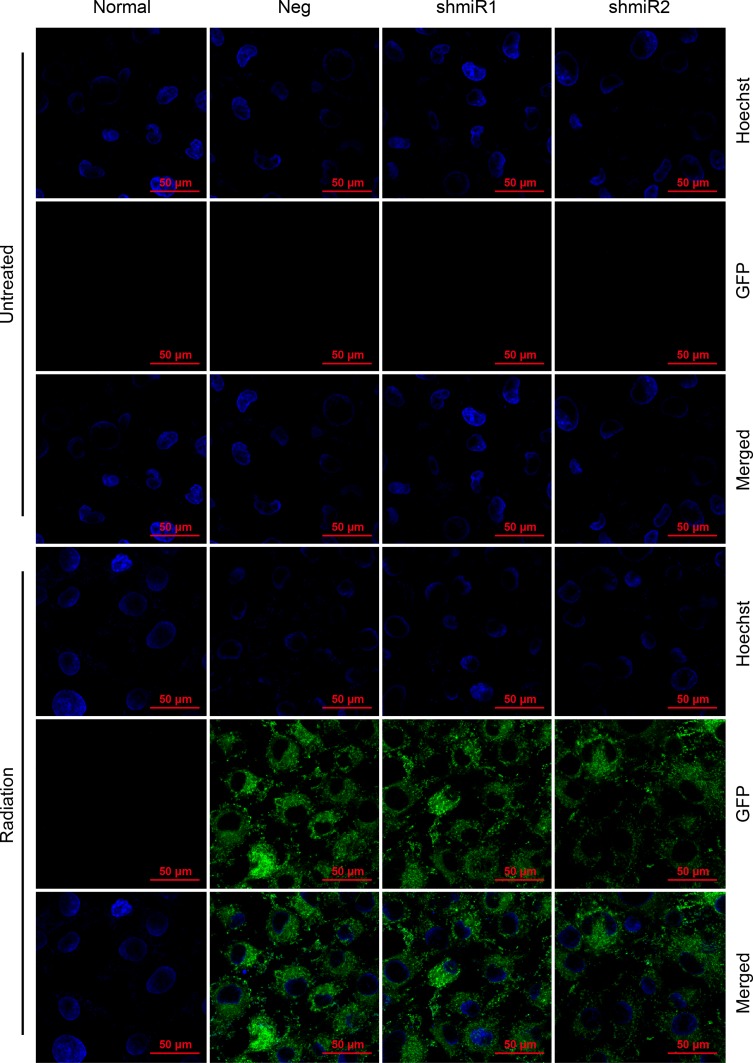
GFP expression in SK-BR-3 cells treated for 48h by laser confocal microscopy.The figures showed above were merged photos in which cell nucleus was dyed with Hoechst 33342. The green fluorescence was prominent after 48 hours. Normal: cells without treatment; Neg: cells stably expressed shRNA-neg-miR-155; shmiR1: cells stably expressed shRNA-1-miR-155; shmiR2: cells stably expressed shRNA-2-miR-155; Radiation: cells receiving 6 Gy of radiation treatment.